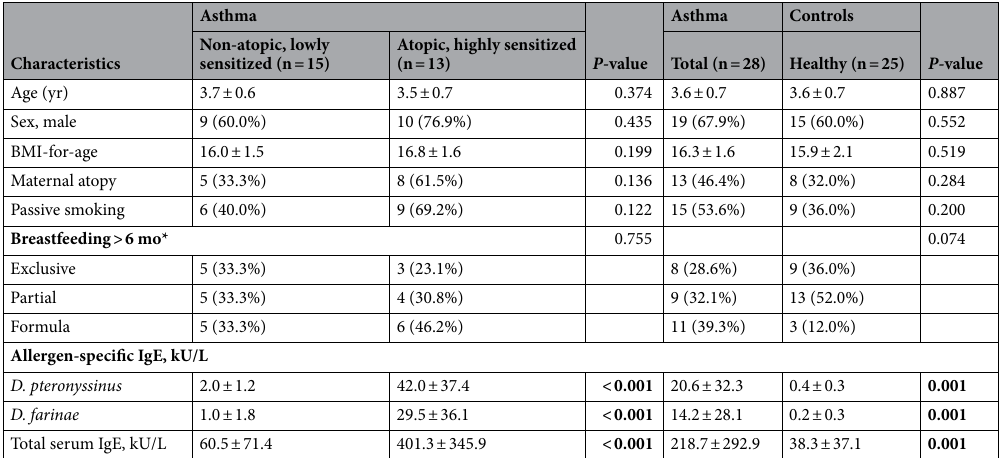
Table 1. Comparison of the clinical and epidemiologic characteristics between lowly and highly sensitized asthma, and healthy controls. Data shown are mean ± SD or number (%) of patients as appropriate. yr year, BMI body mass index, IgE immunoglobulin E. Significance values are given in bold. *Breastfeeding for the first 6 months of